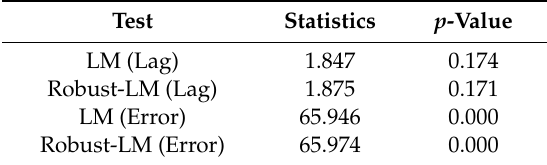
Table 5. LM and robust LM test results of space lag e ff ect and space error e ff